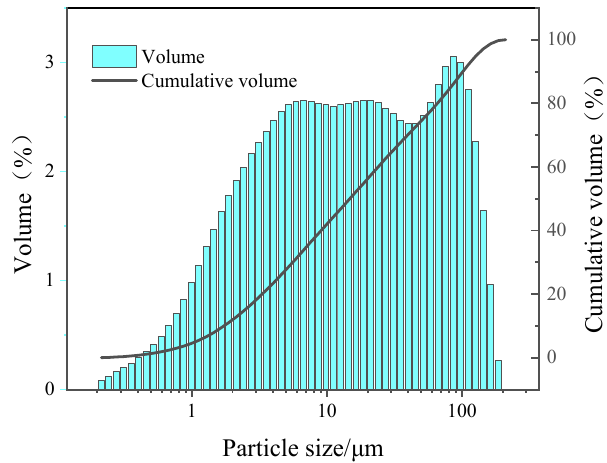
Figure 3. The SEM images of RP [56].